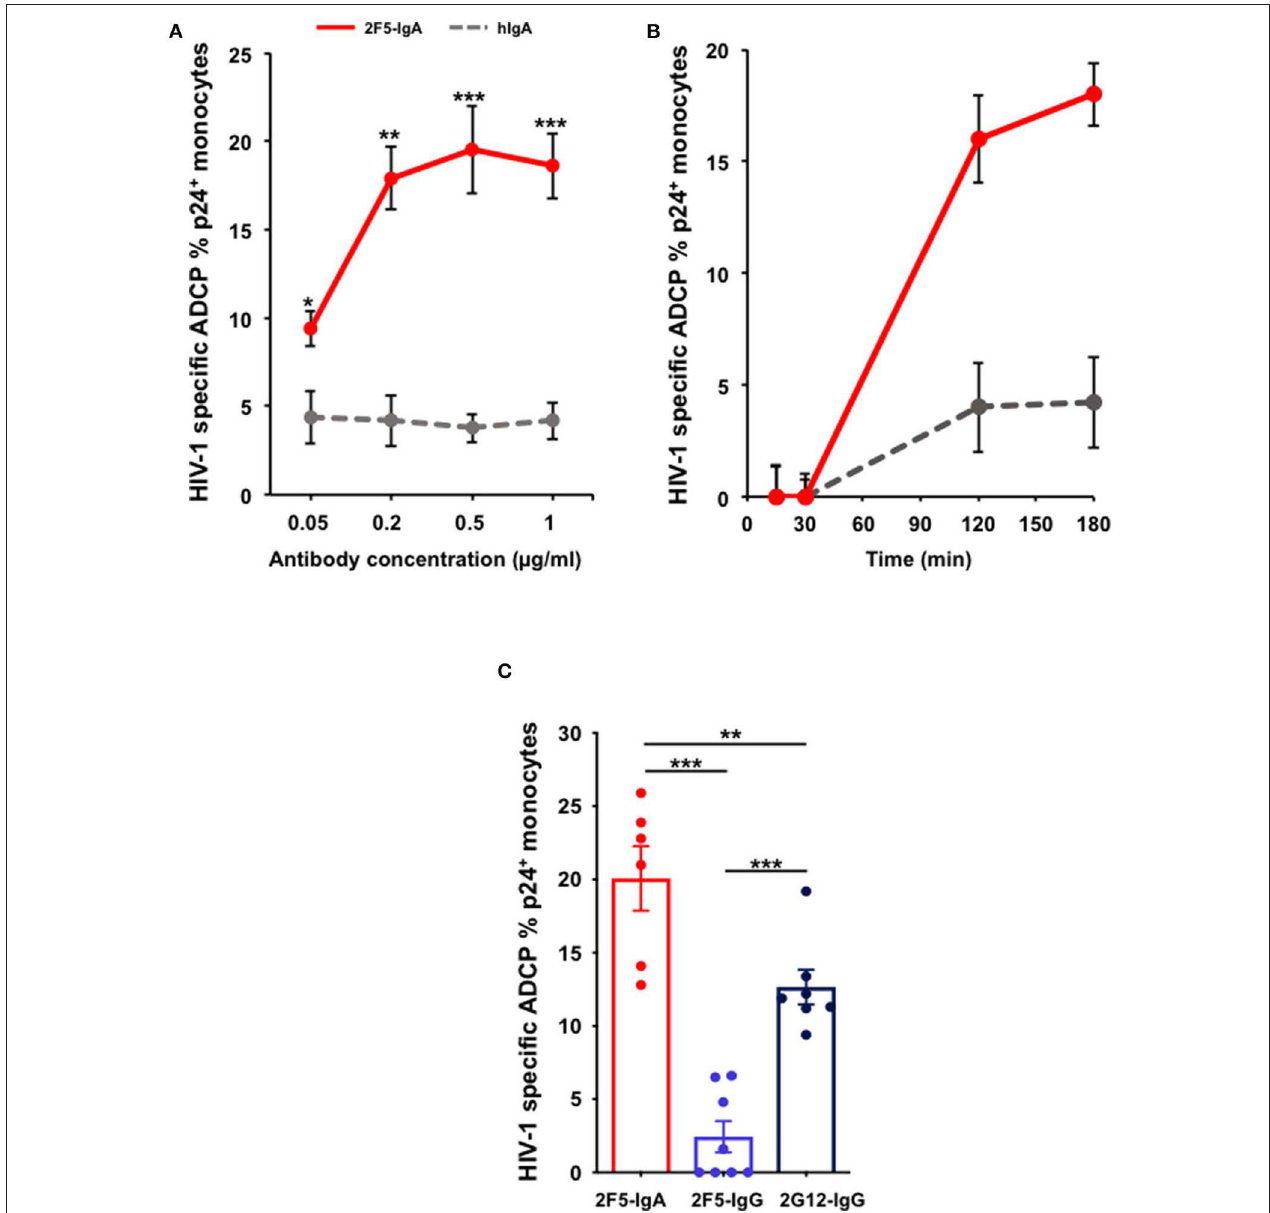
FIGURE 3 | 2F5-IgA mediates ADCP of HIV-1-infected primary CD4 + T lymphocytes by monocytes more efficiently than 2F5-IgG and 2G12-IgG. Primary CD4 + T-cells were infected with JR-CSF clade B HIV-1 for 72h and incubated with (A) various concentrations of 2F5-IgA or hIgA2, (B) 0.2 µ g/ml, or (C) 0.5 µ g/ml of 2F5-IgA, 2F5-IgG, 2G12-IgG, or hIgA/IgG for 30min at 37 ◦ C. Primary monocytes were stained with 0.1 µ M intracellular CellTracker TM Deep Red Dye, added to opsonized infected target cells and allowed to phagocyte for 3h at 37 ◦ C. Cells were washed, fixed in PFA, permeabilized before intracellular staining with anti-p24 FITC-coupled Ab and analyzed by flow cytometry. ADCP percentage is determined as indicated in the Method section. In (A,B) , non-specific ADCP mediated by hIgA2 are shown. In (C) , background ADCP % obtained in the presence of hIgA/hIgG was subtracted from ADCP % triggered by HIV-1 specific antibody. Values represent means of HIV-1-specific infected cells ADCP % ± SEM, from 4 independent experiments performed in triplicate, NS p > 0.05, * p < 0.05, ** p < 0.01, *** p < 0.001, unpaired Student’s t -test.